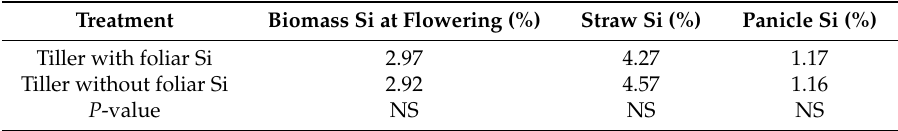
Table 3. Silicon content of biomass and panicle of tillers with and without foliarly applied silicon. Treatment Biomass Si at Flowering (%) Straw Si (%) Panicle Si (%) Tiller with foliar Si 2.97 4.27 1.17 Tiller without foliar Si 2.92 4.57 1.16 P -value NS NS NS